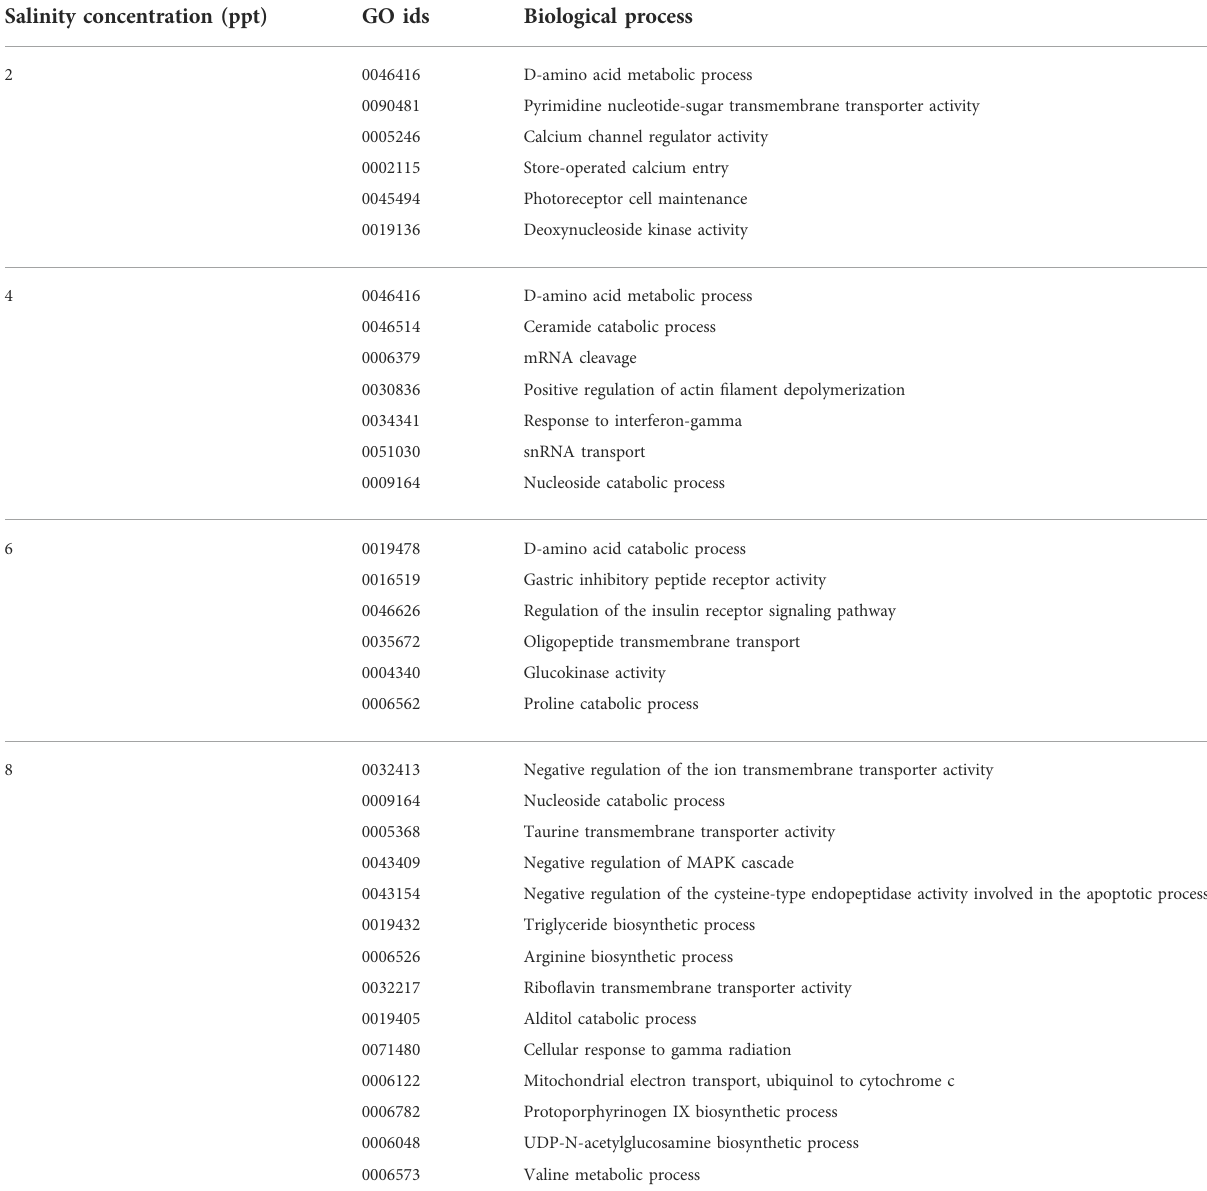
TABLE 2 List of predominantly enriched GO terms with their biological processes (based on the number of genes involved) of the L. rohita kidney transcriptome under increased salinity concentrations obtained from the ClueGO network analysis of DEGs. Salinity concentration (ppt) GO